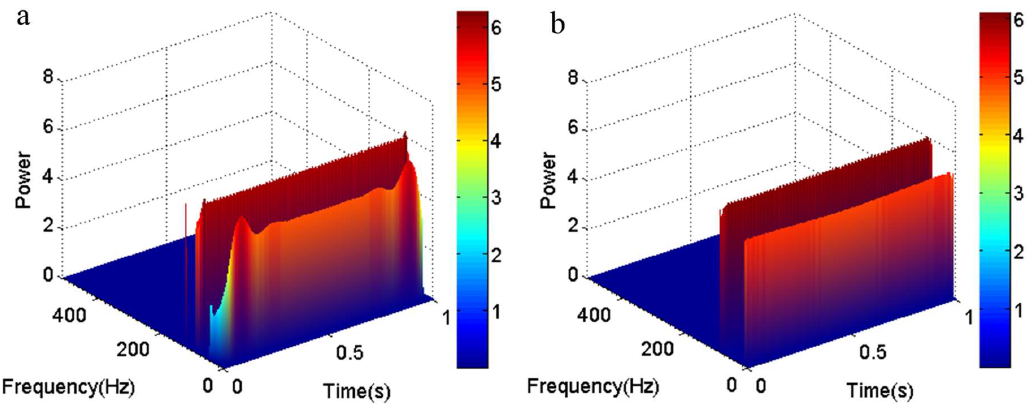
Figure 4. The three-dimensional time-frequency-power spectrum. ( a ) The three-dimensional time-frequency-power spectrum obtained by the original EMD method; ( b ) The three-dimensional time-frequency-power spectrum obtained by the local linear extrapolation method.